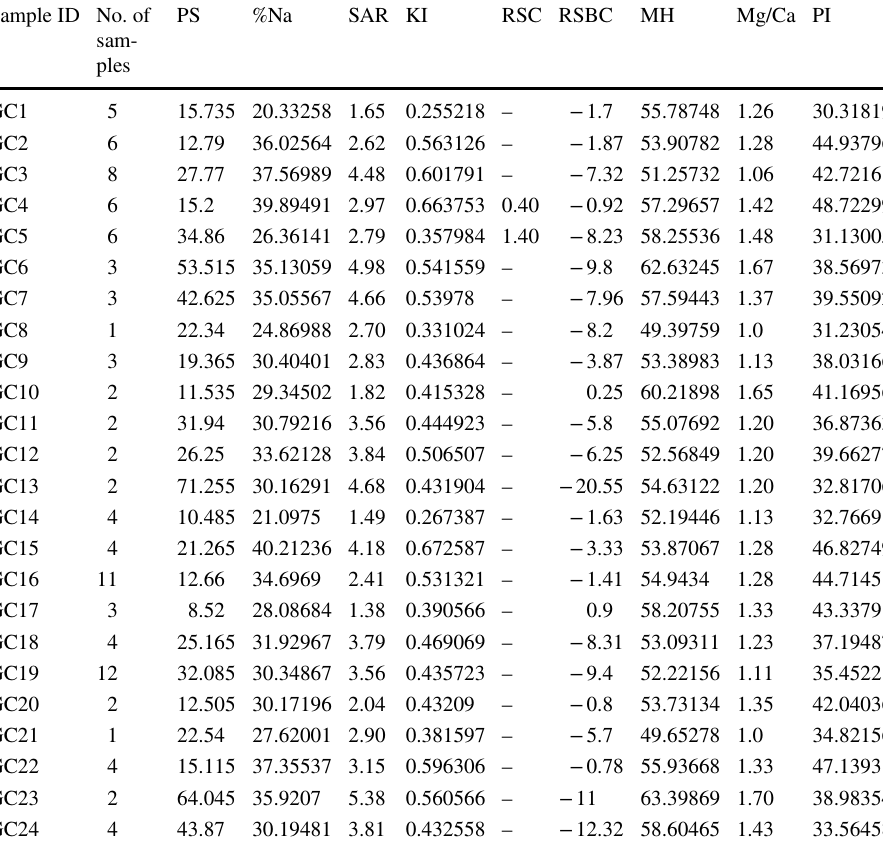
Sample ID No. of sam-